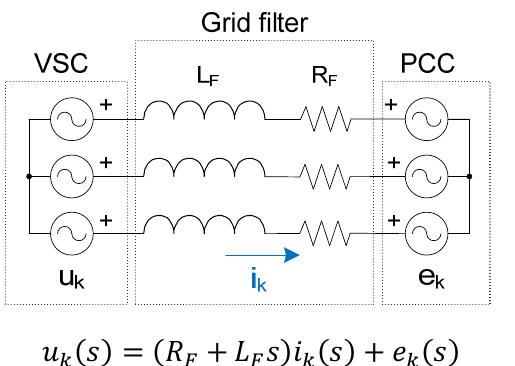
Figure 11. Equivalent model of the